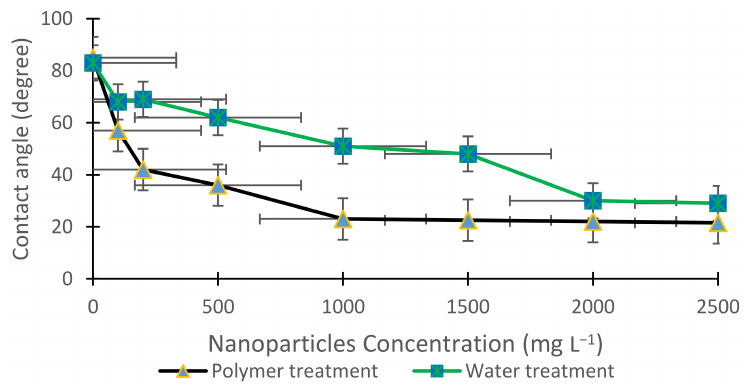
Figure 3. Contact angle measurement in the presence of different nanoparticle